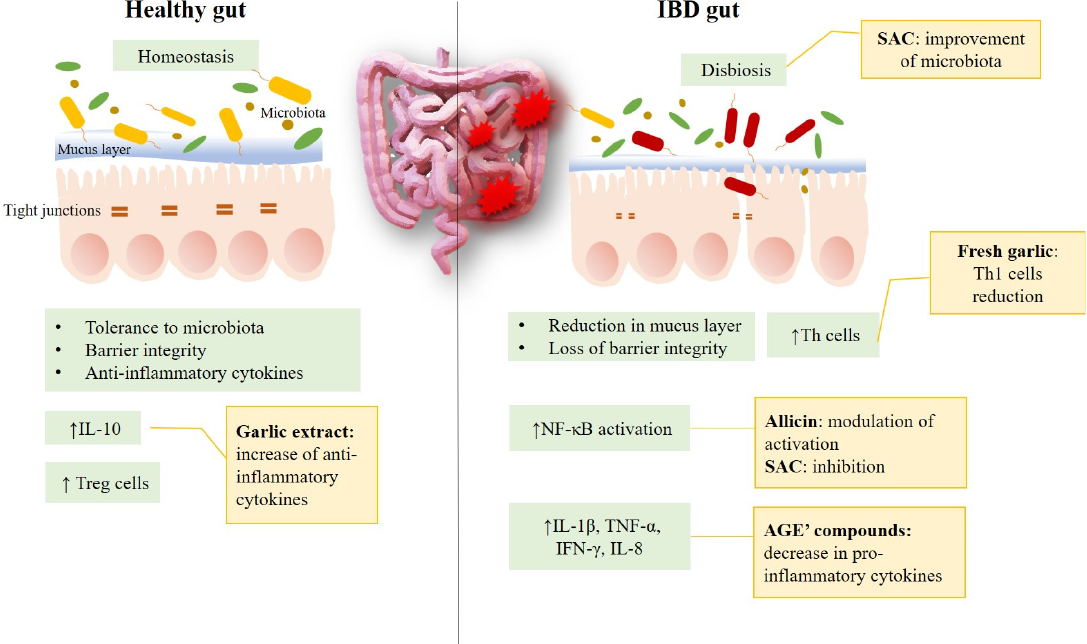
Figure 3. Some targets of garlic and its components at the intestinal level. Garlic and its compounds affect intestinal well-being at different levels. In the healthy gut, they can contribute to increasing the anti-inflammatory cytokines; in the case of disease, they have a role in improving microbiota and reducing inflammation, since they act on the key elements of IBD inflammation.